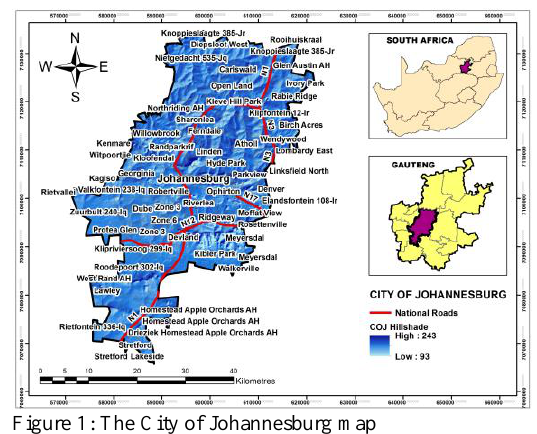
Figure 1: The City of Johannesburg map Johannesburg consists of approximately 4.4 million people, accounting for about 36% of the Gauteng population and 8% of the national population (Todes, 2012). Johannesburg is the economic and financial hub of South Africa. Its economy and contribution to the national economy, has grown substantially and performed well on all major indicators when compared to other Metros. It contributes about 17% of the national GDP and approximately 47% of Gauteng’s economy. Johannesburg ranked 47 out of 50 top cities in the world as a worldwide centre of commerce (the only city in Africa) (Angel et al., 2005). However, massive challenges in terms of urban poverty, inequality, unemployment, food insecurity, social exclusion and underdevelopment still